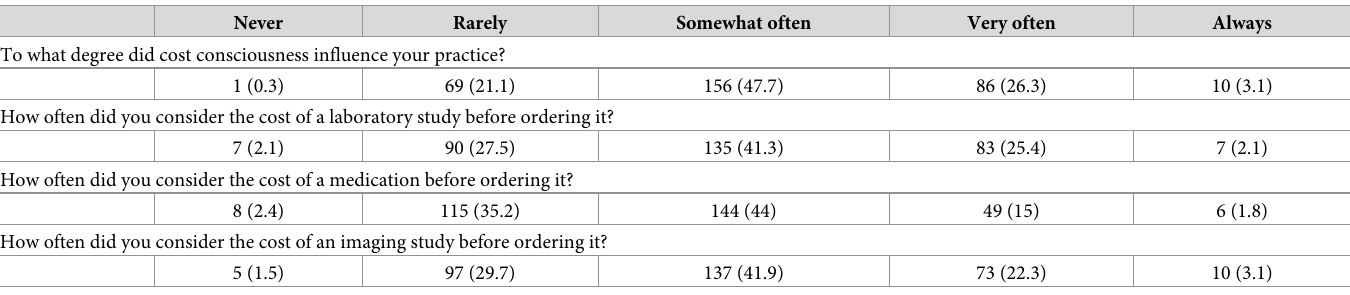
Table 2. Self-reported